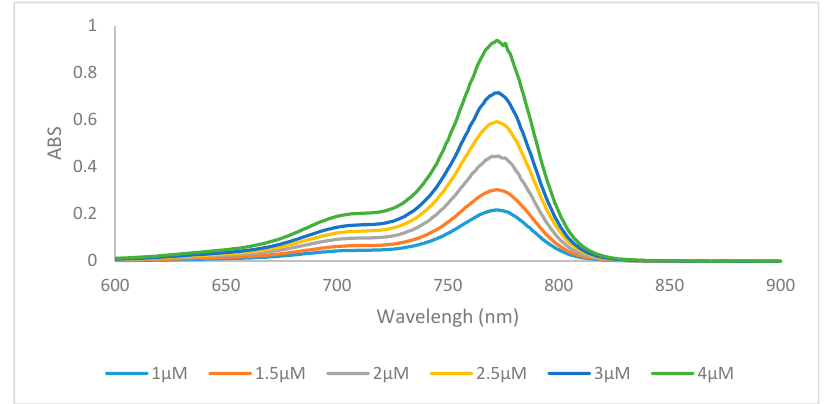
Figure 2. Absorption spectra of dye 6m in ethanol.